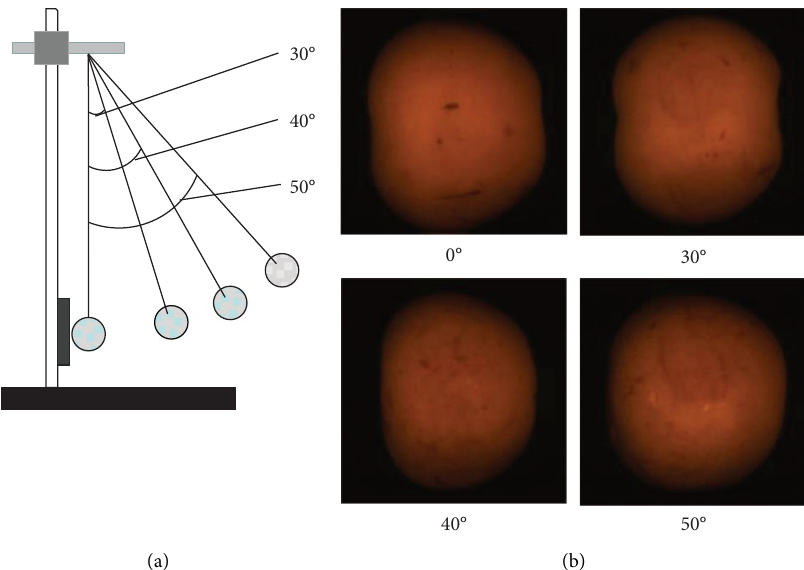
Figure 1: Pendulum quantitative damage of the experimental setup: (a) pendulum quantitative damage device, schematic; (b) sound and diferent levels of damage of the crown pear samples.